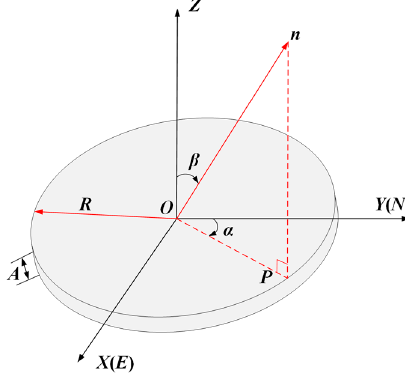
Figure 2. Baecher disc model .